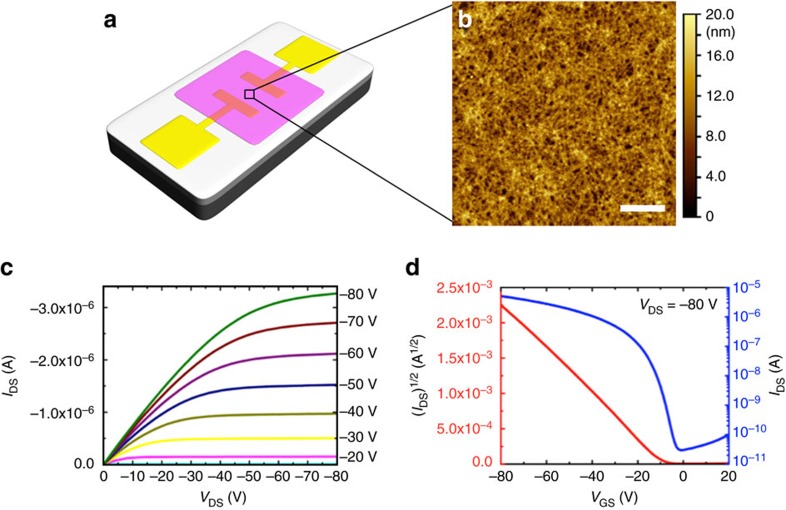
OFETs fabricated from the rrP3HT-b-rsP3HT and rrP3HT-b-PS fibres.(a) Schematic illustration of the bottom-gate, bottom-contact OFET device (structures not drawn to scale; purple: semiconducting film; yellow: gold source/drain electrodes; light grey: dielectric SiO2 layer; dark grey: gate Si electrode). (b) AFM image of rrP3HT106-b-rsP3HT47 fibres (cast from 0.1 mg ml−1 anisole solution). Scale bar, 1 μm. The representative (c) output and (d) transfer characteristics of the OFET device of the unfragmented rP3HT106-b-rsP3HT47 fibres (Ln>10 μm) (IDS=drain-to-source current; VDS=drain-to-source bias; VGS=gate-to-source bias).